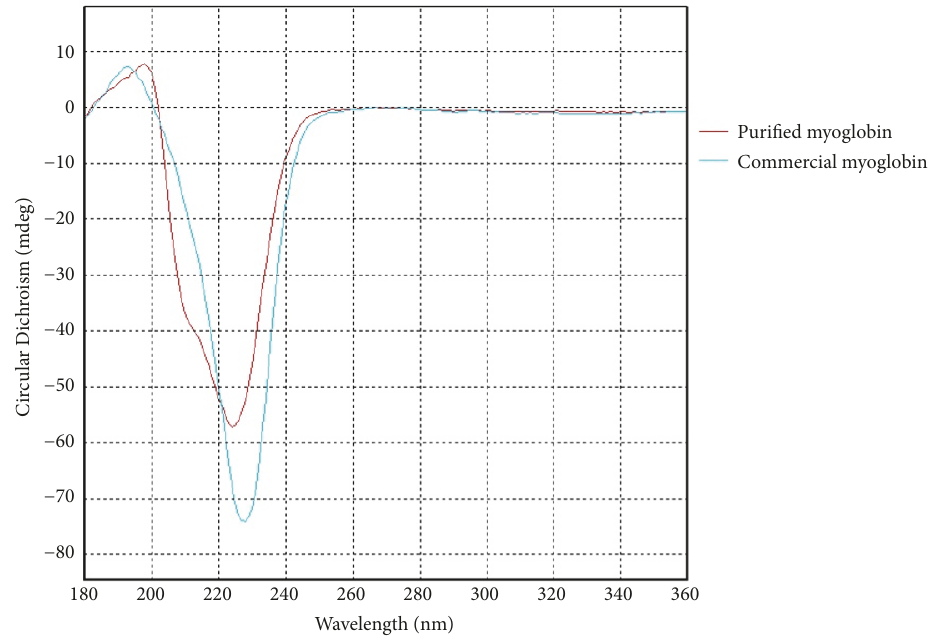
Figure 8: CD spectra of purified myoglobin and commercial